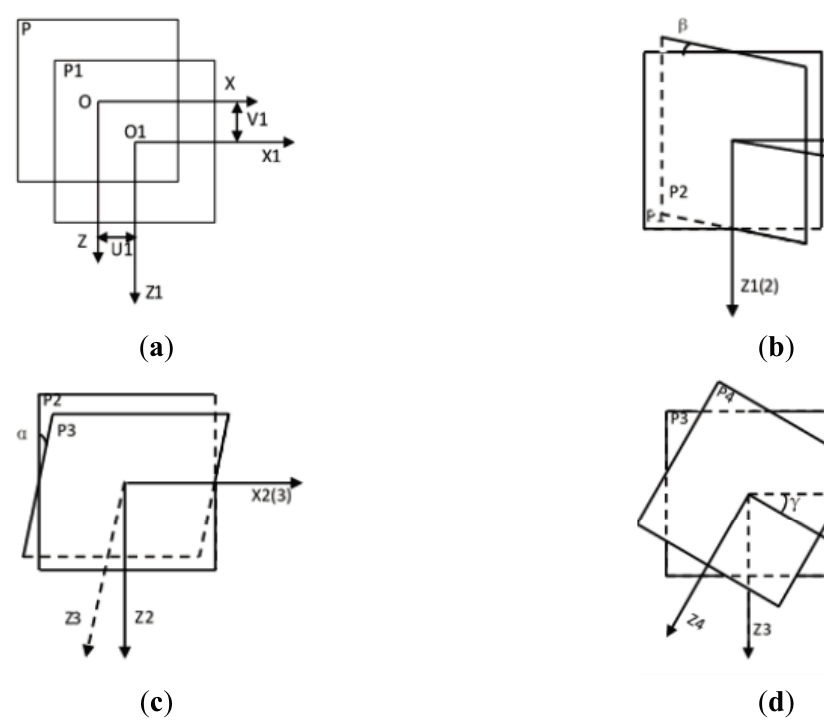
Figure 2. Misalignments of the detector. ( a ) The skewing of detector along X and Z axis; ( b ) the angle of detector tilt around Z axis; ( c ) the angle of detector tilt around X axis; and ( d ) the angle of detector tilt around Y axis.